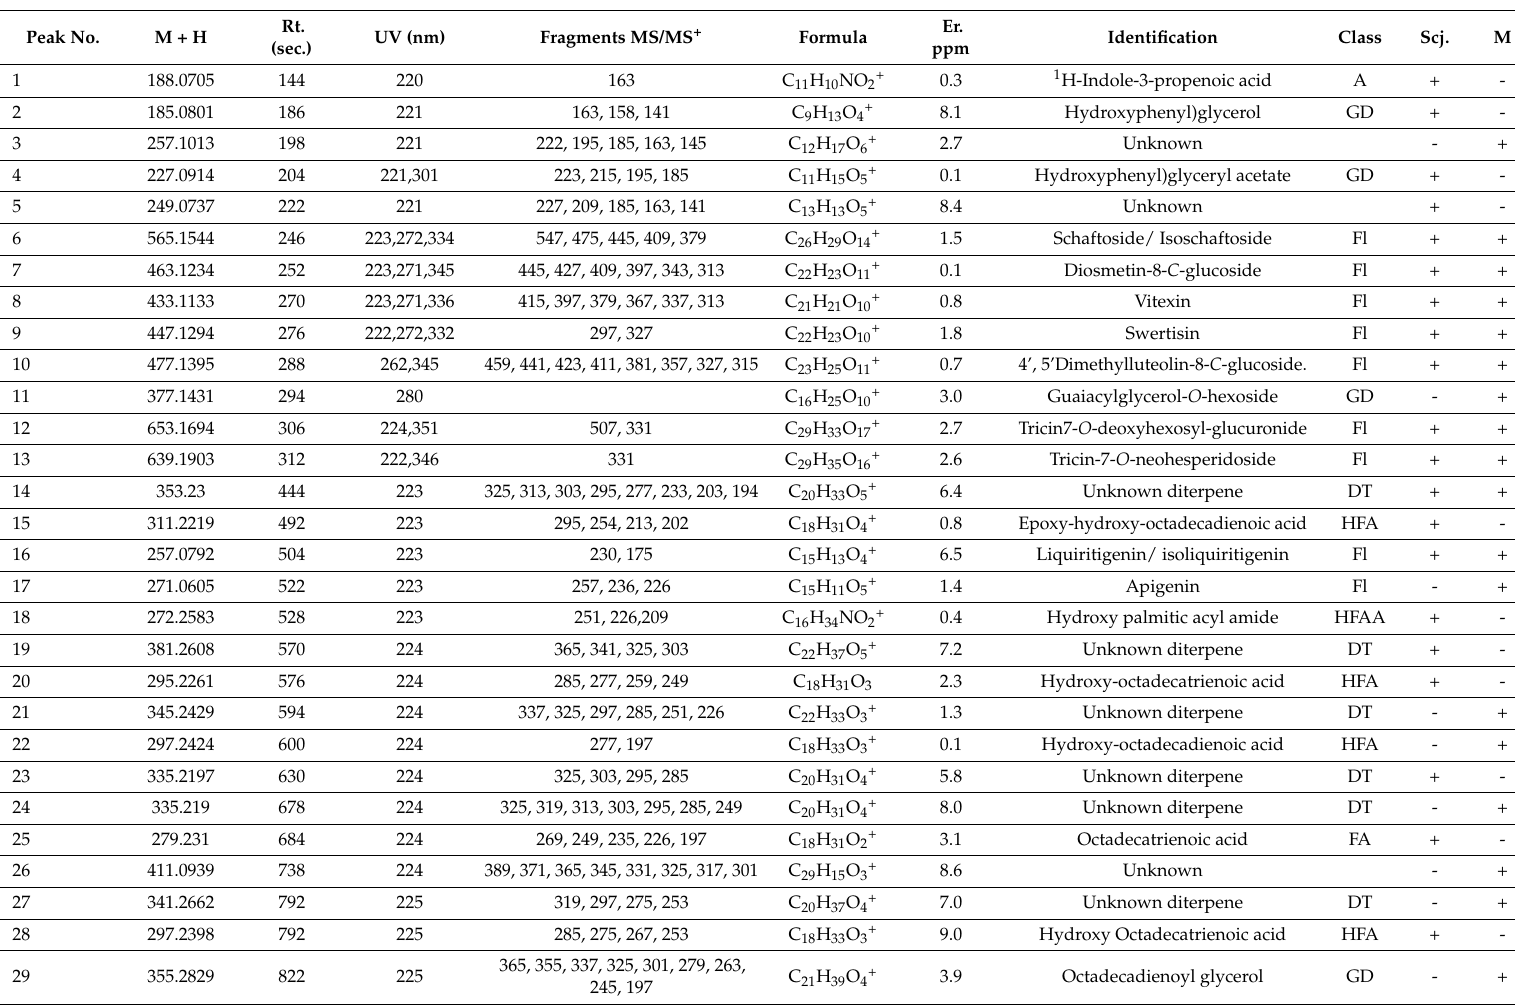
Table 3. Metabolite assignments for peaks tentatively identified in UPLC-UV-ESI-MS chromatograms of molasses and sugarcane juice in positive ionization mode. Peak